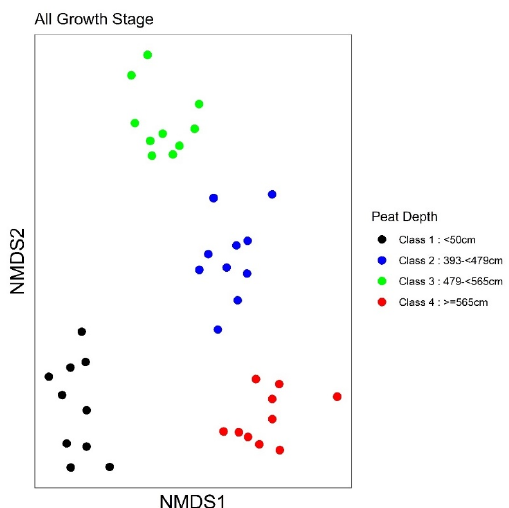
Fig. 5: The non-metric multidimensional scaling (NMDS) plot for the composition of tree species at peat depths of <50 cm, 393-<479 cm, 479-<565 cm, and ≥565 cm